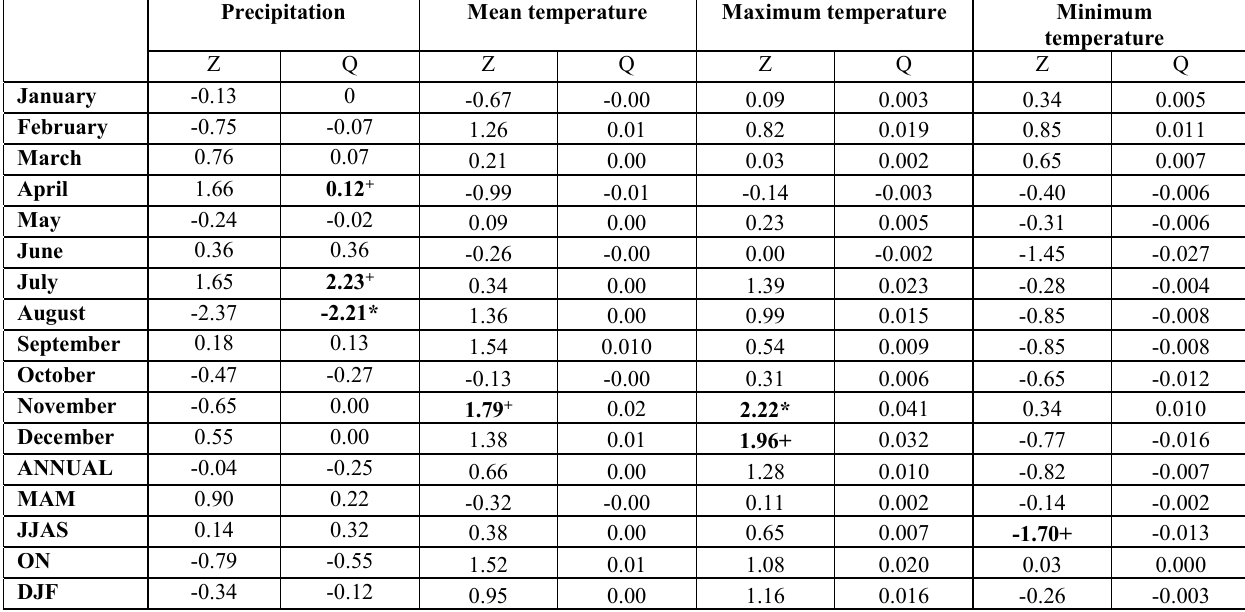
Table 1. Results of statistical test (MK- test and Sen’s estimate) for seasonal and annual precipitation over the period 1971-2015 in